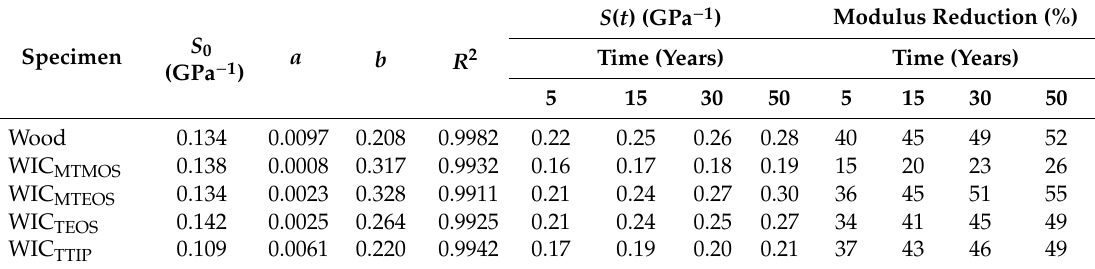
Figure 5. SSM-predicted creep data of wood and WICs prepared from MTMOS, MTEOS, TEOS, and TTIP. Table 2. SSM-predicted creep compliances of wood and wood-inorganic